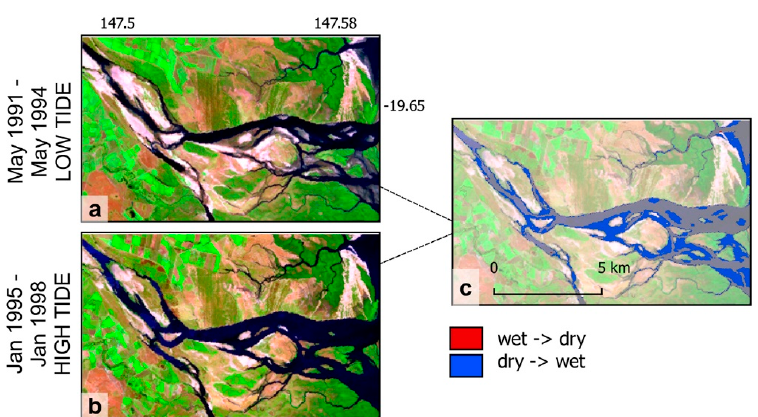
Figure 8. Change detection with the influence of tides: composites either side of a non-flooding period (see Figure 7b,c) generated from observations at different stages of the tidal cycle; lowest 20th ( a ) and highest 20th ( b ) percentile of the OTR. Analysis using the NDWI illustrates the importance of constraining to a common tidal range for change applications, with large areas of change driven by varying tides identified in ( c ), when compared to the constrained analysis shown in Figure 7f for the same time periods.